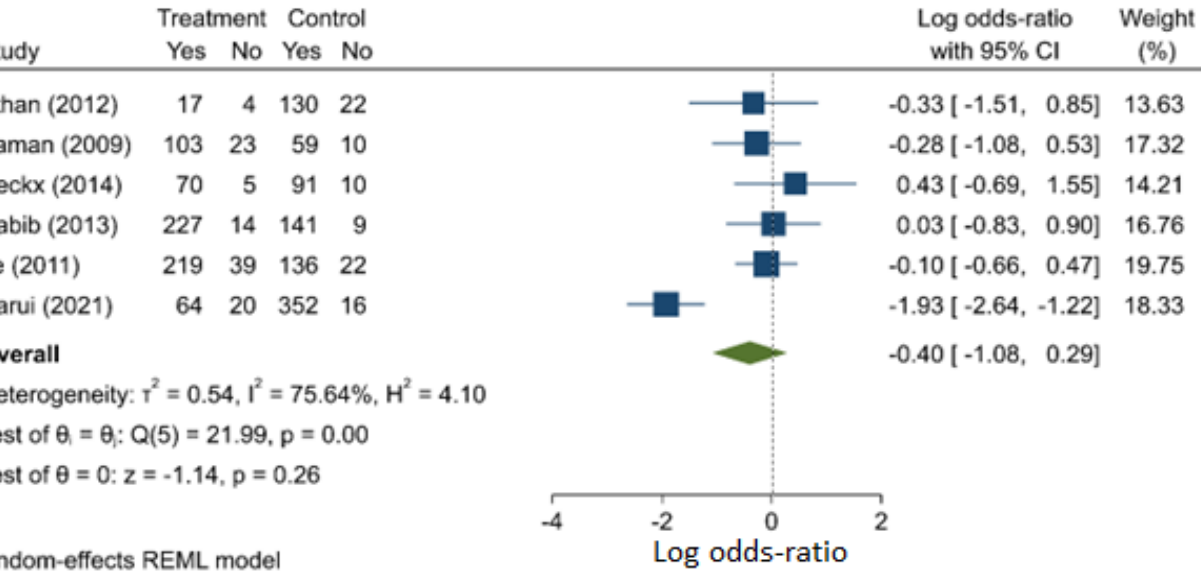
Figure 7. Implantable cardioverter defibrillator compared with anti-bradycardic CIED (pacemaker) as a risk factor for mortality.